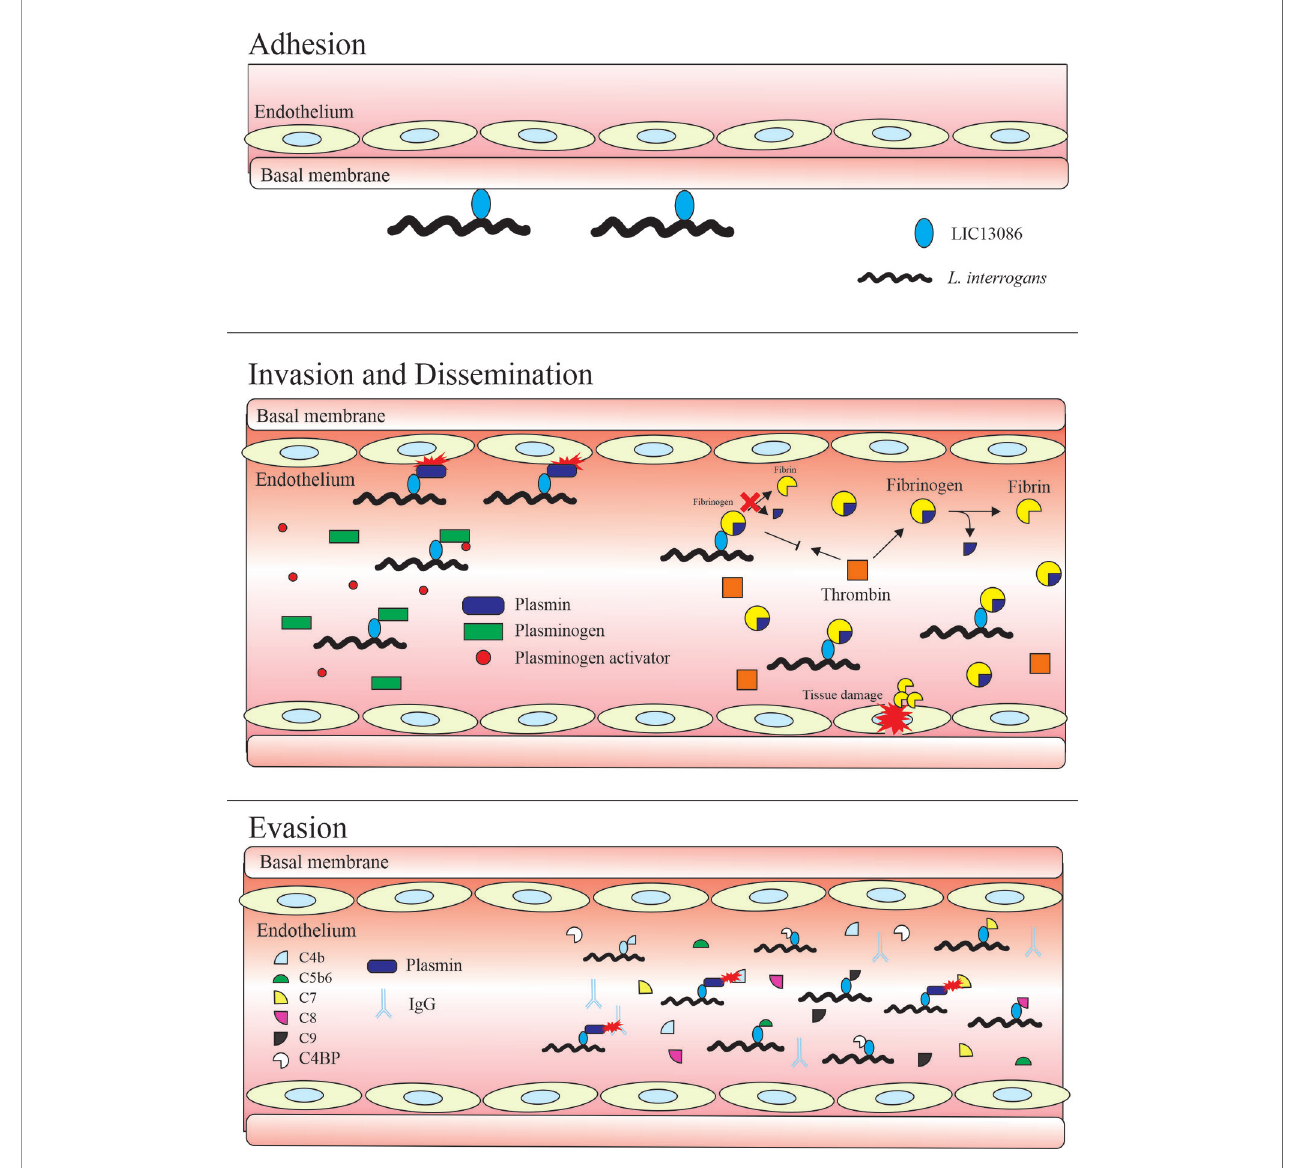
FIGURE 10 | Schematic model representing the possible roles of the protein LIC13086 in Leptospira – host interactions and pathogenesis. LIC13086 is a putative lipoprotein experimentally shown to be located in the leptospiral outer membrane. By binding to ECM and basal membrane components, namely laminin, LIC13086 can participate in the adhesion process of leptospires to the host tissues. The binding of LIC13086 to plasminogen/plasmin can contribute to bacterial dissemination, invasion, and immune evasion, through various mechanisms. The plasminogen is fi rst recruited to the bacterial surface via bacterial receptors, including LIC13086. The leptospiral-bound plasminogen is converted into plasmin by host-derived plasminogen activators, such as uPA. Plasmin is able to degrade ECM and basal membrane components, resulting in enhanced bacterial penetration and tissue damage. Plasmin also cleaves immunoglobulins and complement molecules, thus favoring immune evasion. By binding to fi brinogen, LIC13086 inhibits its cleavage by thrombin, thus reducing fi brin formation, which can have a consequence in the loss of hemostasis. The complement system comprises various components and regulators. By sequestering the host complement proteins and regulators through various surface proteins, including LIC13086, leptospires can inhibit the complement deposition on the outer membrane, thus avoiding the membrane attack complement (MAC)